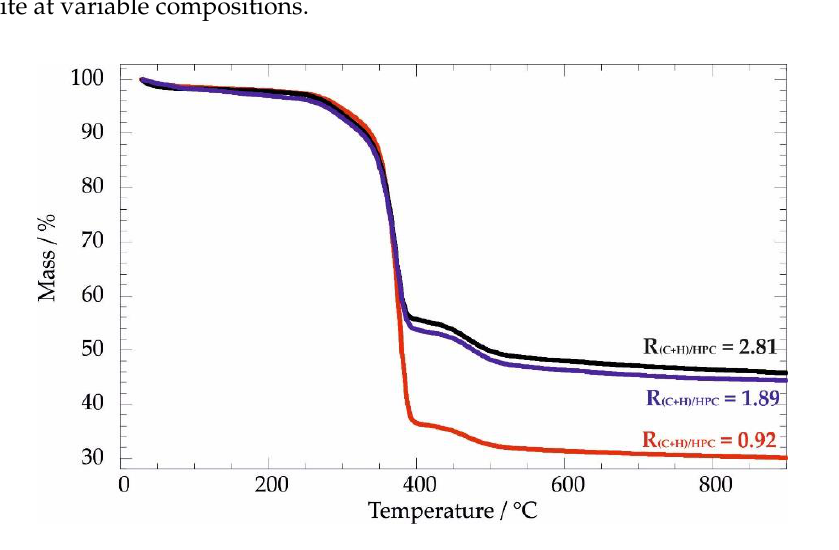
Figure 2. The thermogravimetric curves for the nanocomposites at variable compositions.